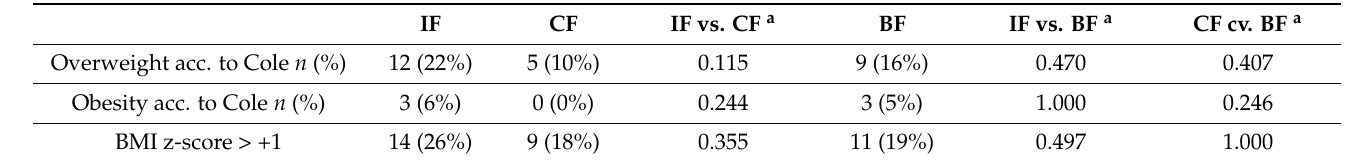
Table 4. Number (%) of overweight, obese or BMI z-score > +1 children at seven years of age for the intervention group (IF), control group (CF) and formerly breastfed infants (BF).